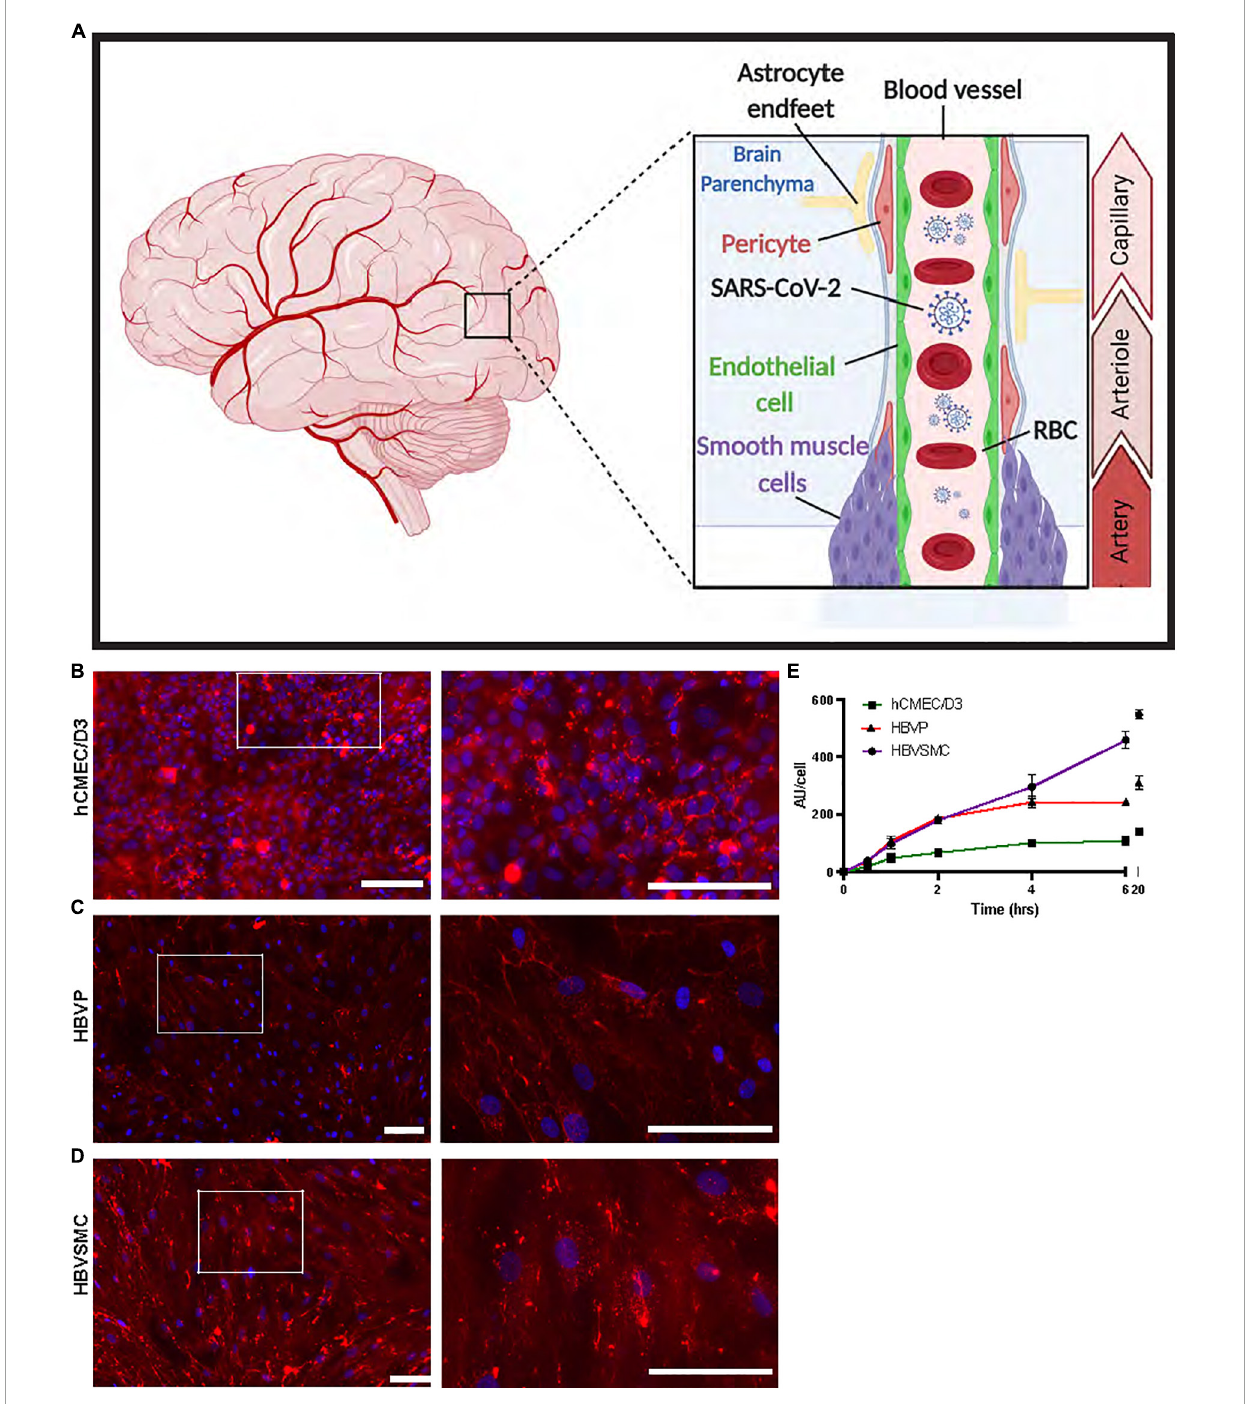
FIGURE1 Progressive increase in SP uptake by cerebrovascular cells over time. (A) Schematic diagram showing the location of the three human cerebrovascular cell types used in this study [micro-vessel/capillaries endothelial cells (hCMEC/D3), pericytes (HBVP) and vascular smooth muscle cells (HBVSMC)]. Created by using BioRender.com. (B–D) Representative images of SARS-CoV-2 spike protein (SP)-555 (red) uptake, at 4 h, counter stained with 4’,6-diamidino-2-phenylindole (DAPI). Images on the right are the white boxed areas. (E) SP-555 uptake over time for the hCMEC/D3 (green), HBVP (red) and HBVSMC (purple). AU = Fluorescence arbitrary unit. Values are mean ± SEM. N = 3 to 6 wells per group. Scale bar = 100 µ m.